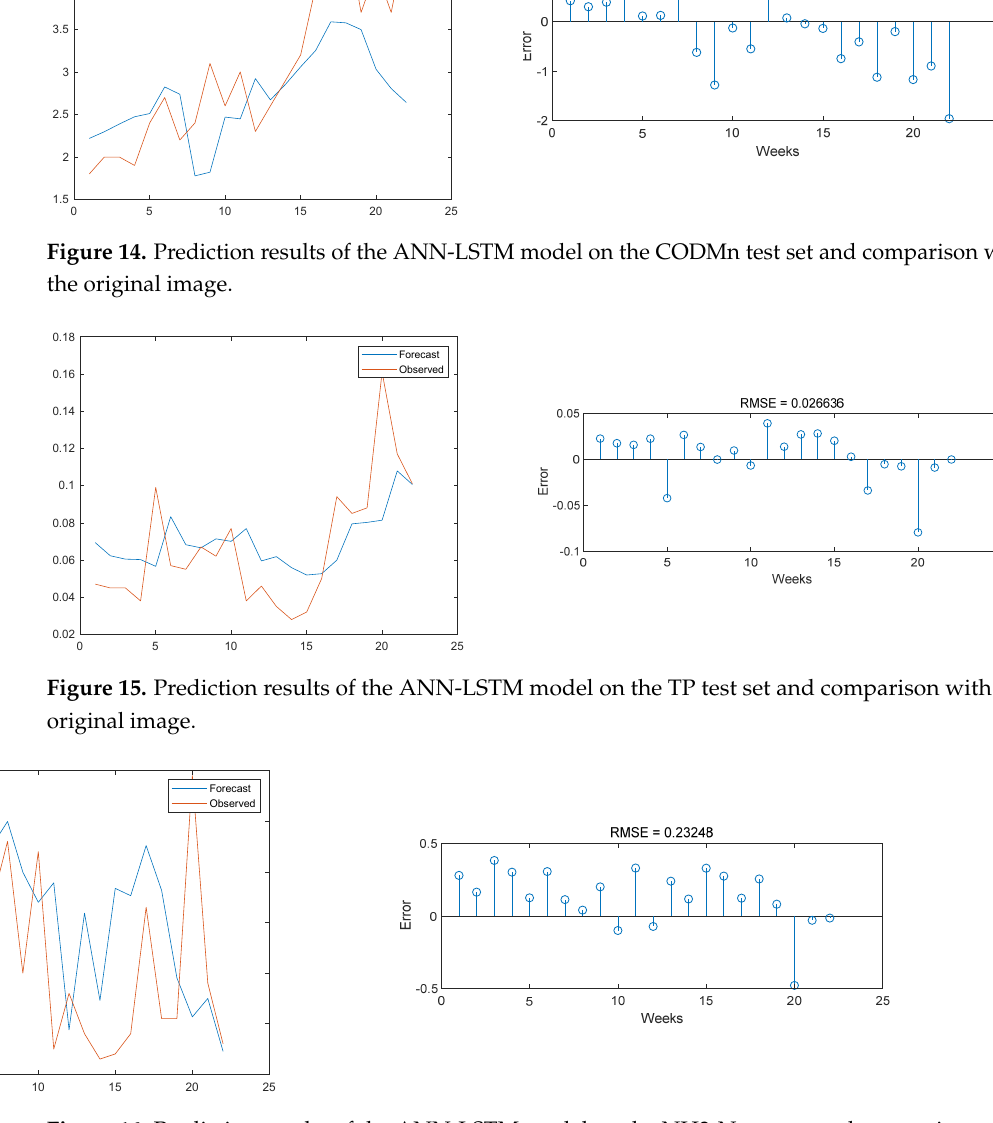
Figure 16. Prediction results of the ANN-LSTM model on the NH3-N test set and comparison with the original image.